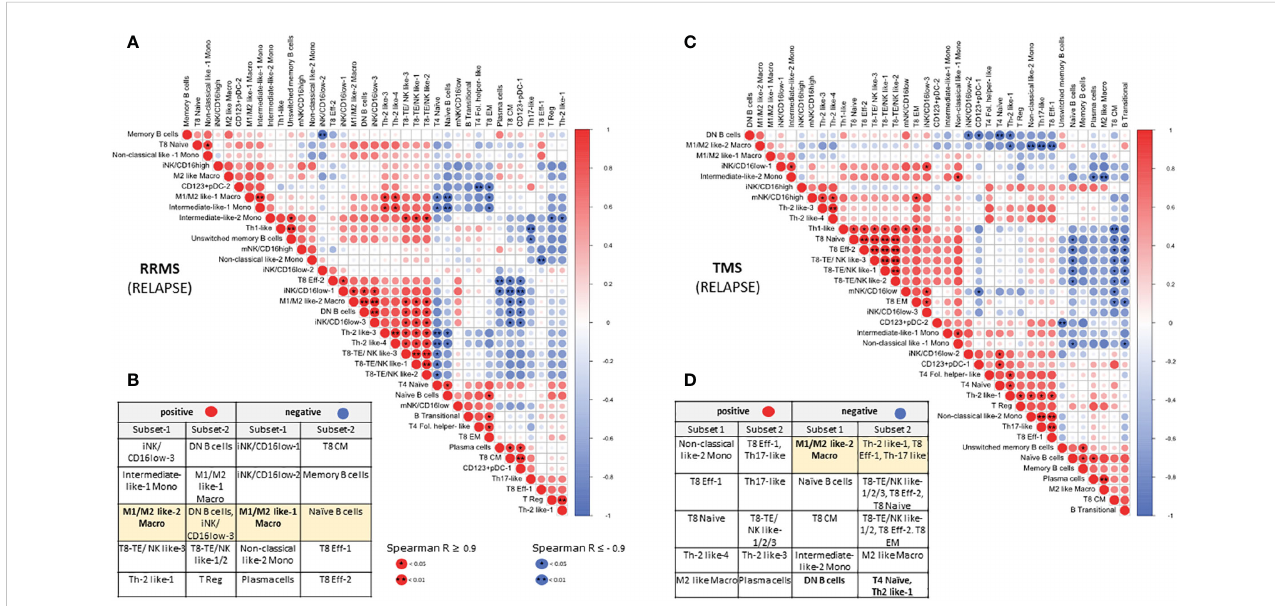
FIGURE 8 Correlation matrix of immune subsets in relapsing MS (RRMS and TMS) patients. Relationships between immune subsets in RRMS during relapse (matrix A and table B) and TMS patients during relapse (matrix C and table D). In the matrices, (A, C) correlations are color-indicated (red for positive, blue for negative). Selected top signi fi cant positive correlations with a Spearman R >0.9 and negative R <-0.9 are shown in tables, (B, D) *p <0.05, **